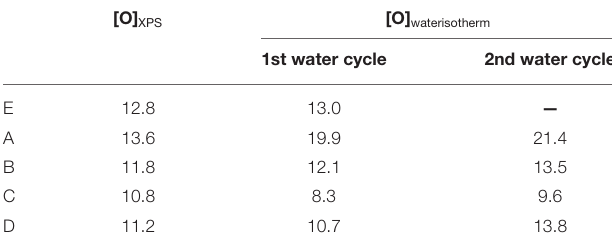
TABLE 4 | Comparison between the XPS oxygen contents and the ones calculated from the water sorption isotherm (%